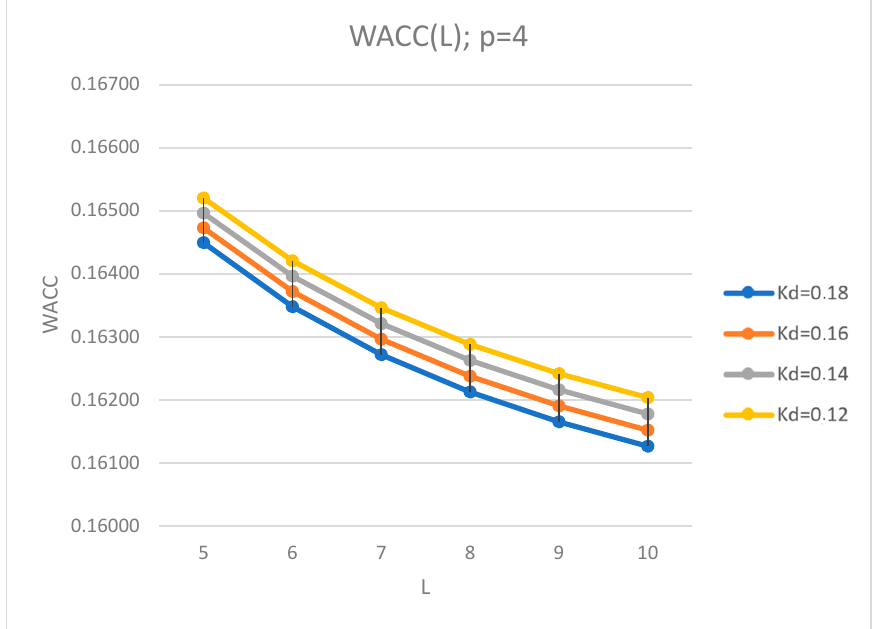
Figure 7. Dependence of the weighted average cost of capital ( WACC ) on leverage level L at different k d (12%; 14%; 16%; 18%) and fixed frequency of payments of tax on profit p = 4 (larger